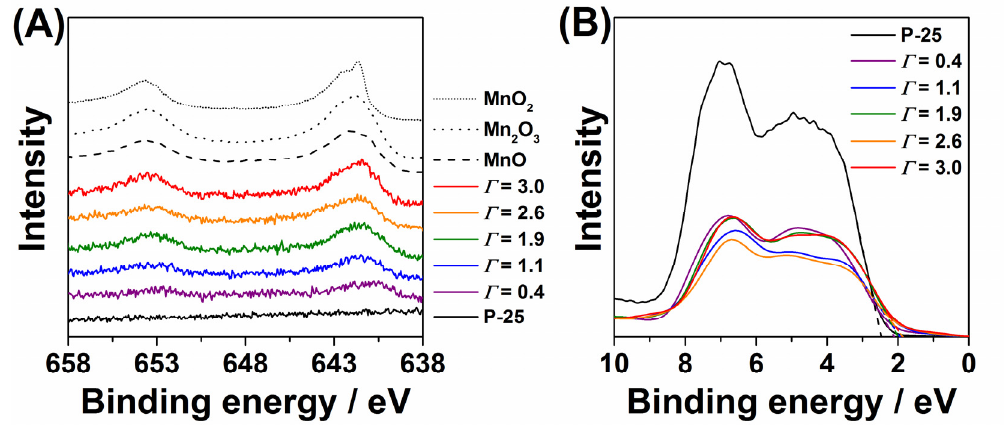
Figure 4. Mn2p-XPS ( A ) and valence band-XPS; ( B ) spectra of MnO varying Mn-loading amounts ( Γ /ions nm − 2